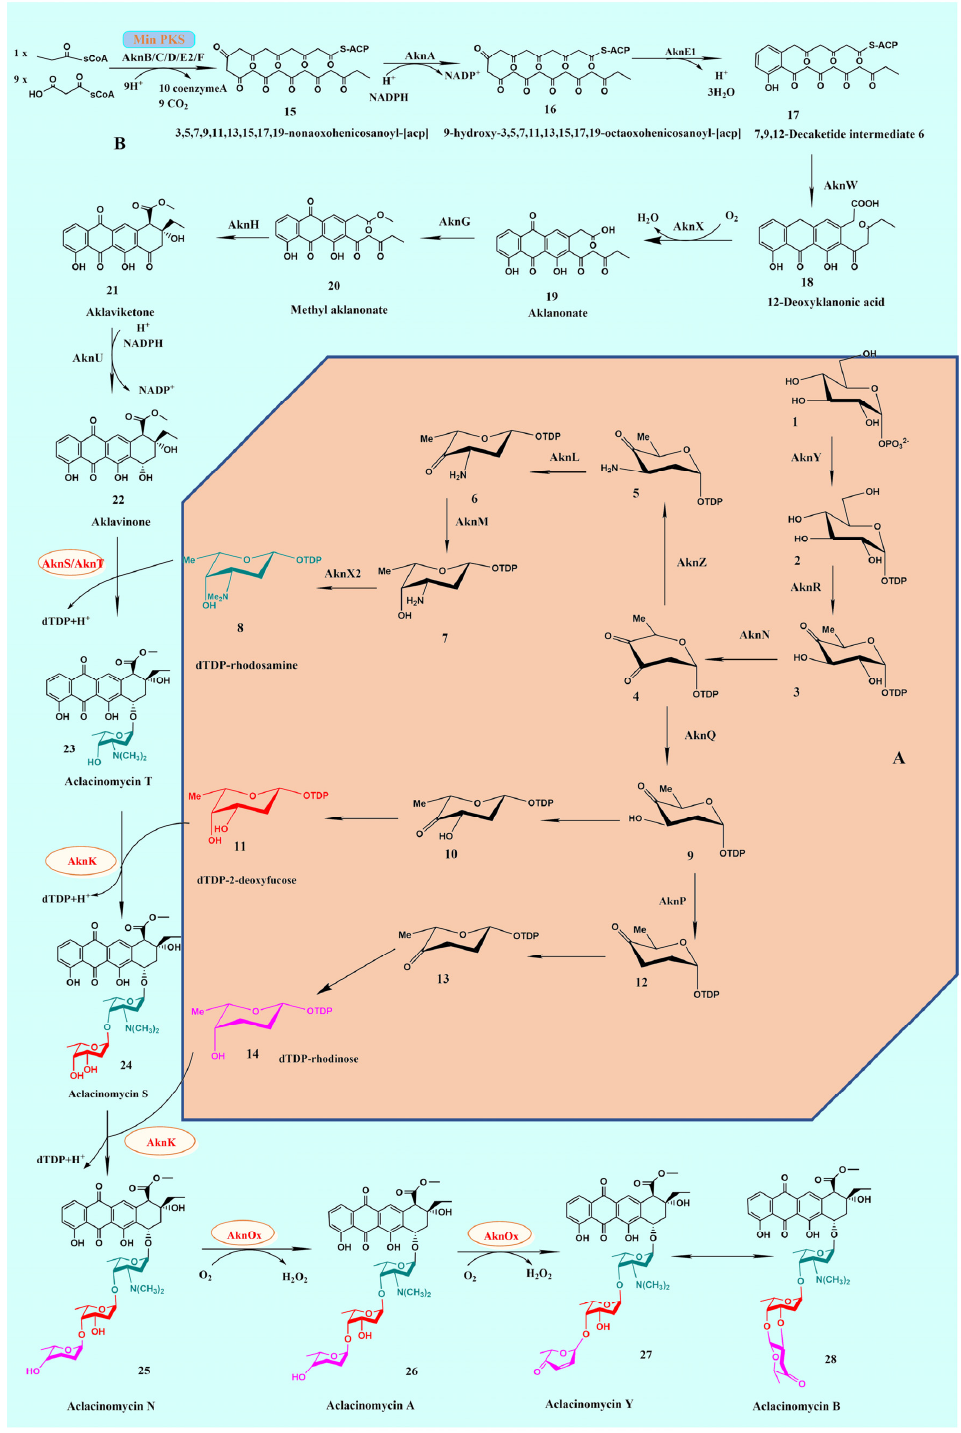
Figure 3. Biosynthesis pathway of aclacinomycin A. ( A ) Biosynthesis of TDP-sugars; ( B ) Type II PKS pathway and post-PKS tailoring modifications.